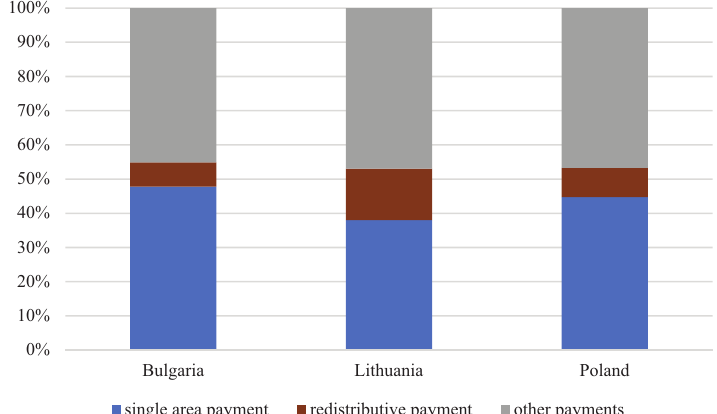
Figure 1. The structure of the national ceilings of the countries under analysis in 2018 (source: au- thor’s own work on the basis of the data provided by the Ministry of Agriculture, Food and Forests of the Republic of Bulgaria, the Ministry of Agriculture of the Republic of Lithuania and the Minis- try of Agriculture and Rural Development of the Republic of